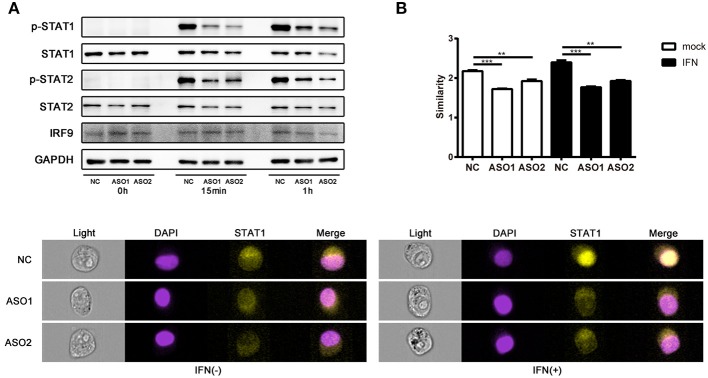
Linc00513 affects the phosphorylation of STAT1 and STAT2 in type I IFN pathway. (A) Western blotting of hela cells transfected with NC or specific ASOs (200 nM) for 24 h and then stimulated with type I IFN (1,000 U/ml) for 15 min or 1 h. Blots are representative of three repeated experiments. Quantification of band intensities analysis was shown in Figure S4. (B) Flow imaging cytometry of hela cells transfected with NC or specific ASOs (200 nM) for 24 h and then stimulated with type I IFN (1,000 U/ml) for 30 min. Cells were stained with antibody to STAT1 and DAPI after fixation and permeabilization. Values of similarity represent the extent of STAT1 translocation to the nuclei. The data shown are means ± SEM and are representative of three repeated experiments. P-values were analyzed with two-tailed unpaired t-test. **indicates p < 0.01, ***p < 0.001. Cell images are representative of three repeated experiments.